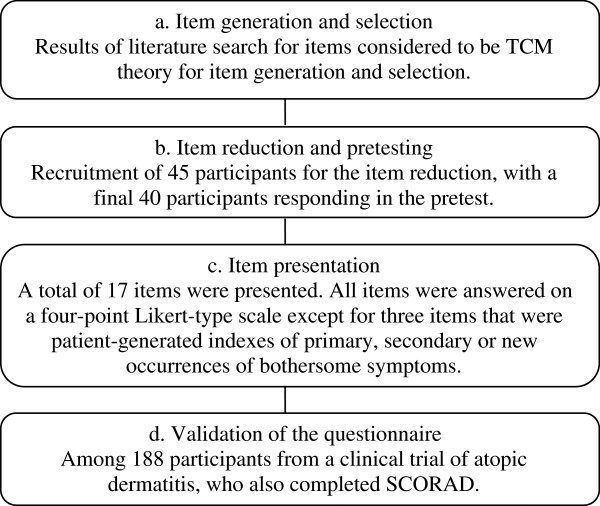
Flow chart of the study phases.